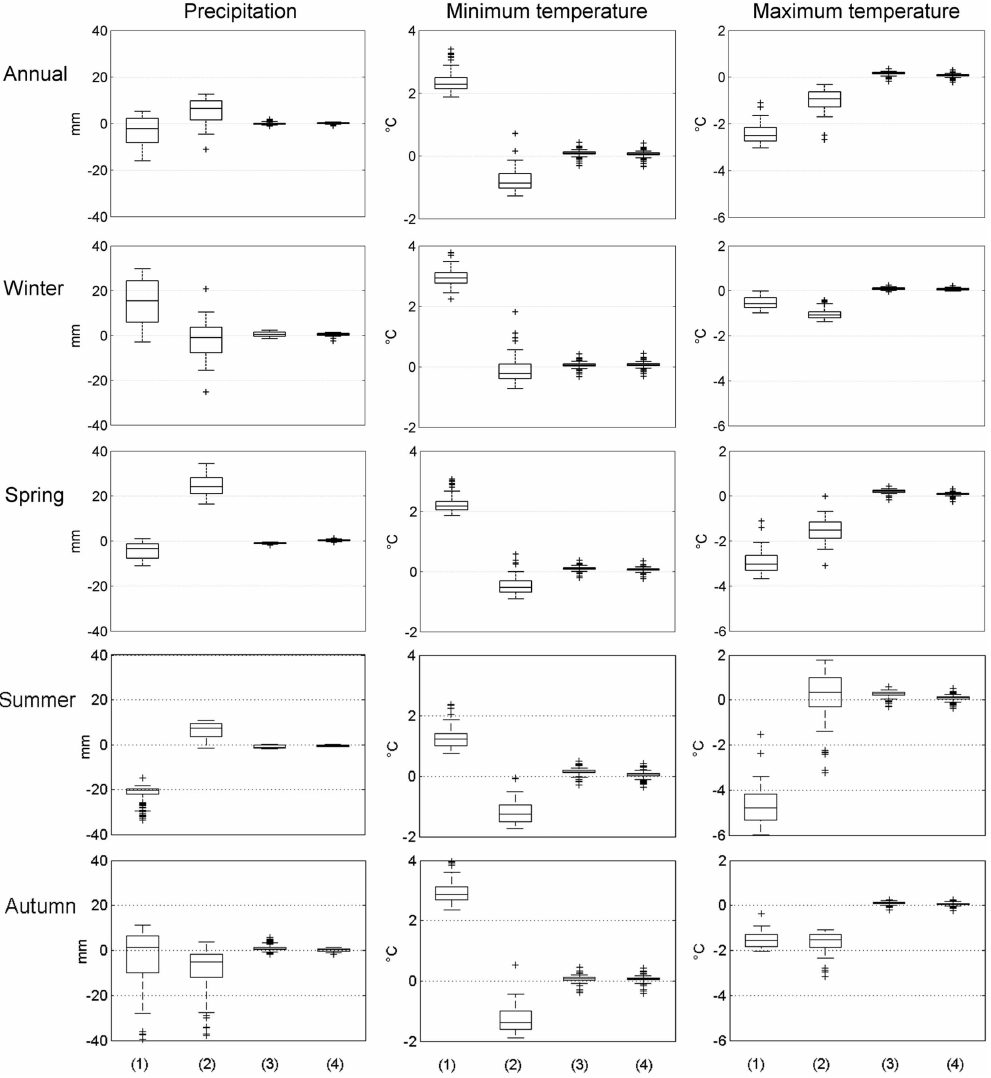
Fig. 5. Annual and seasonal mean bias for precipitation, minimum and maximum temperature computed for land observations (ref), GCM (1), GCM-DD (2), GCM-SD (3), and GCM-DD-SD